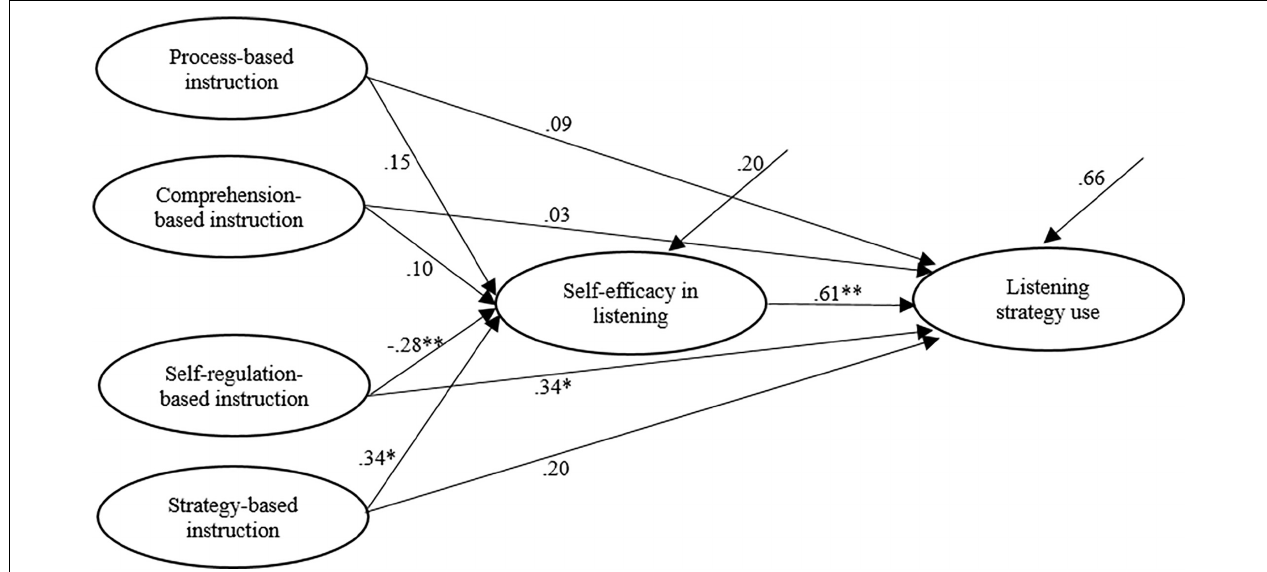
FIGURE 3 | Structural equation model describing the relationships among variables measured in this study. * p < 0.05, ** p < 0.01.